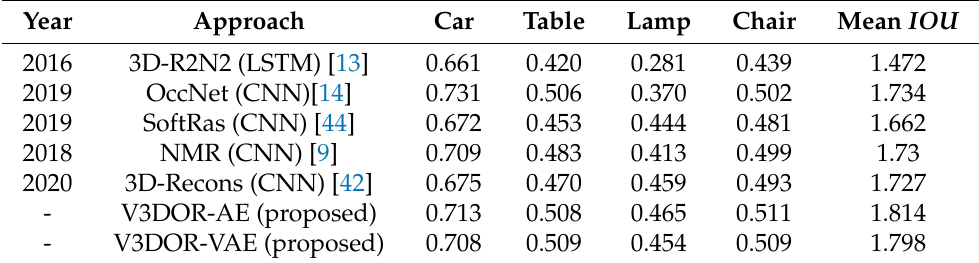
Table 1. Comparison with state-of-the-art methods in terms of IOU . Year Approach Car Table Lamp Chair